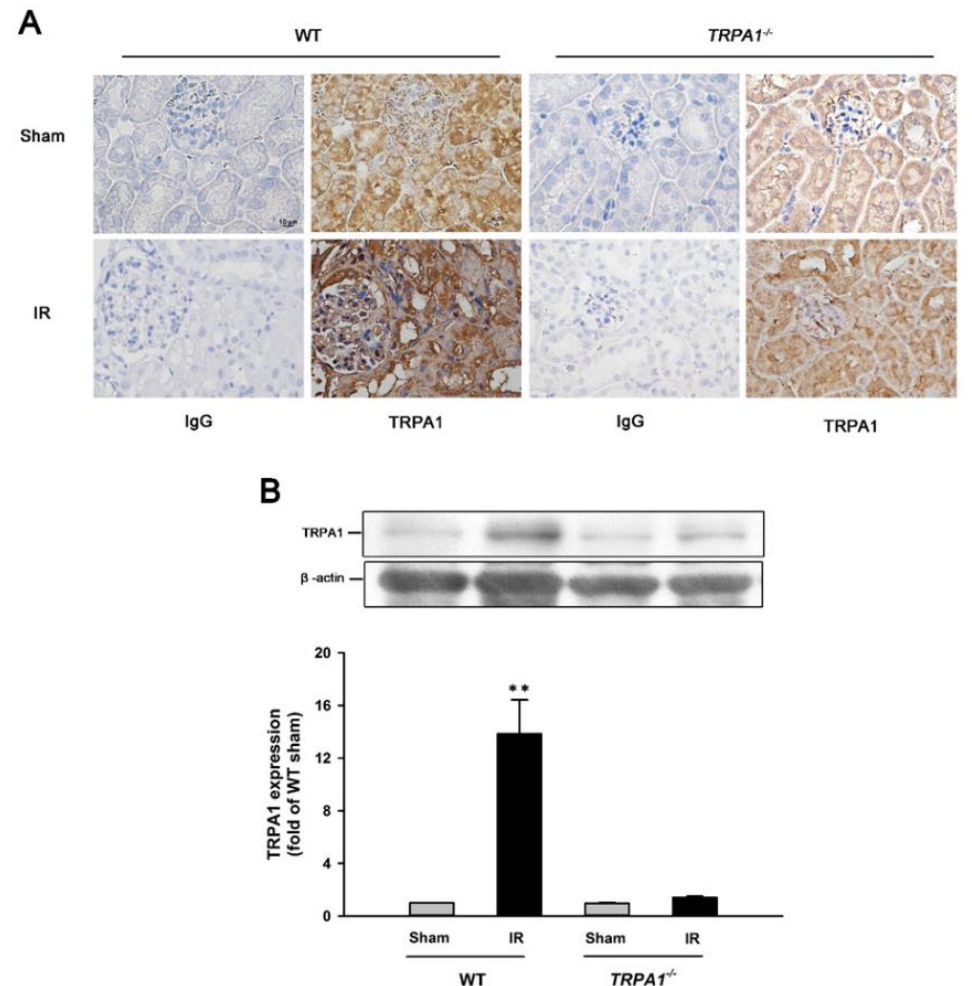
Figure 2. IR increases TRPA1 expression in renal tubular epithelia and renal tissues in wild type (WT) mice, but not in trpa1 − / − mice. ( A ) Representative images showing immunostaining with a TRPA1 antibody. Renal sections were obtained from two genotypes of mice subjected to two different treatments. The specificity of the immunostaining was confirmed using an IgG-negative control. The magnification of each panel was 400 × . Note that the expression of tubular TRPA1 was increased by ischemia reperfusion (IR) only in WT mice. ( B ) Protein levels of TRPA1 in renal tissues obtained from the two genotypes of mice subjected to two different treatments. Protein expression was analyzed by Western blot. Immunohistochemical and Western blot analyses of renal tissues obtained from the trpa1 − / − mice displayed mild TRPA1 protein expression because they were functional knockout mice with the S5/S6 transmembrane domains of targeted gene deleted. Data in each group are mean ± SEM from 6 mice. ** p < 0.01 versus sham treatment. Renal sections from WT mice with IR showed severe tubular injury lesions, manifested by loss of brush border, flattening, and loss of tubular epithelium and nuclear fragmentation. The extent of IR-induced changes was less in the trpa1 − / − mice (Figure 3A). Further analyses revealed that IR increased the tubular injury scores of both genotypes of mice relative to the scores of mice subjected to the sham treatment (Figure 3B). The trpa1 − / − mice with IR had significantly lower tubular injury score than the WT mice with IR (Figure